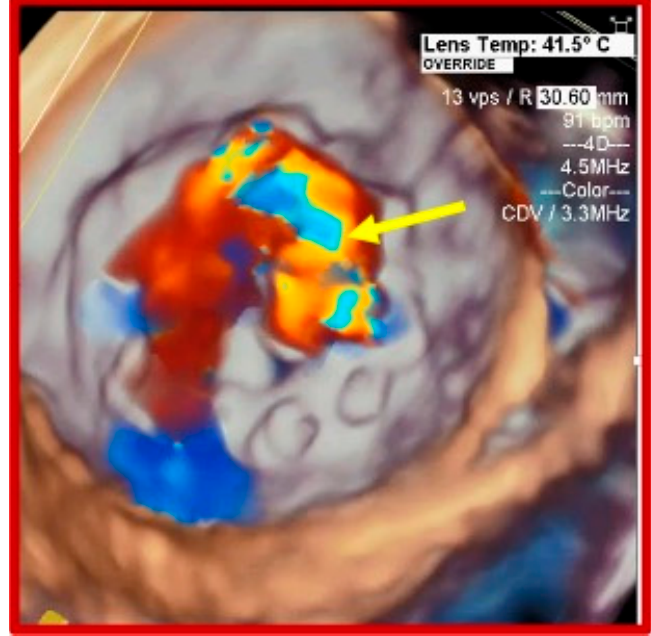
Figure 3. Three-dimensional color doppler transesophageal ECHO showing a large mitral regurgitant get.